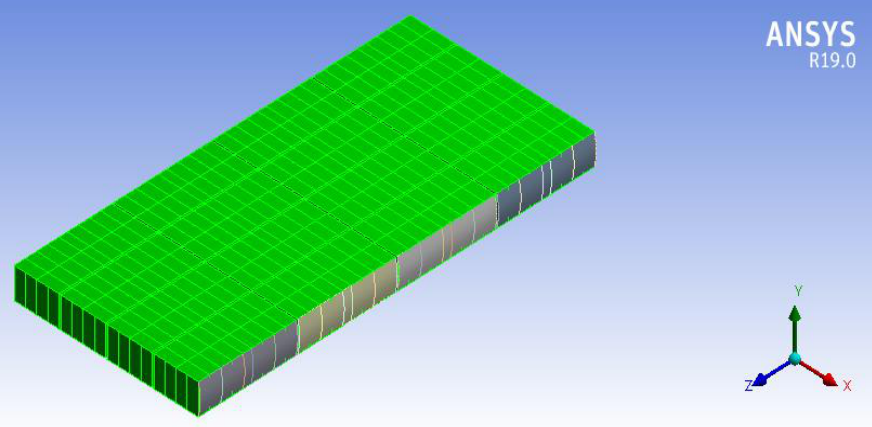
Figure 18. Mitigation panels at the side of the steel ferry.